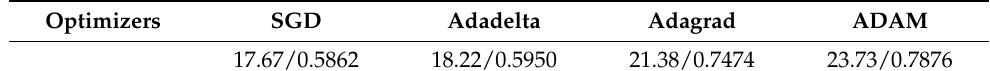
Table 5. Performance effect of different optimization strategies on the Bicubic down-sampled LR images of the Set5 dataset.